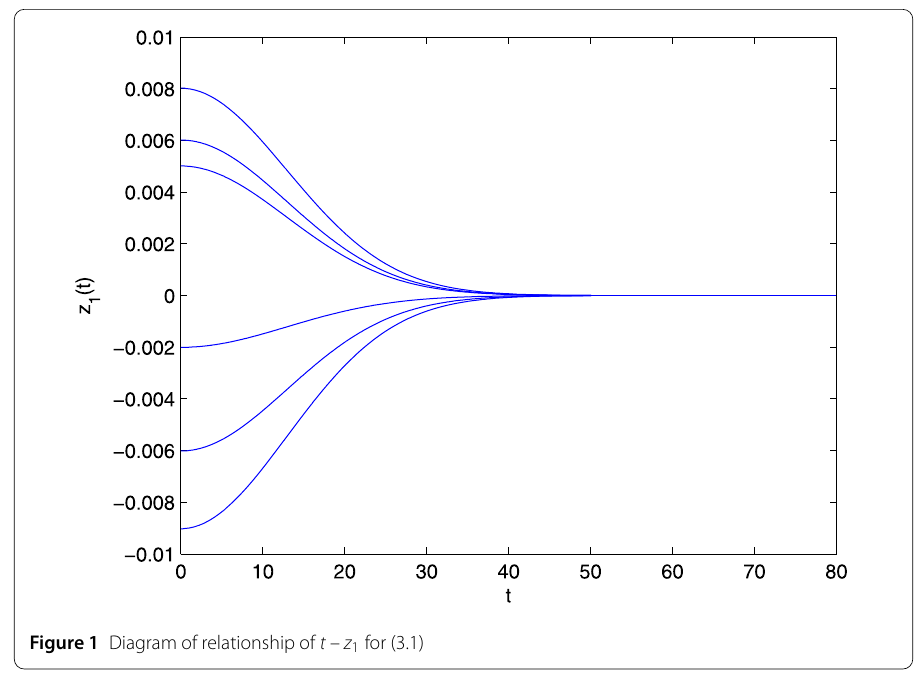
Figure 1 Diagram of relationship of t – z 1 for (3.1)